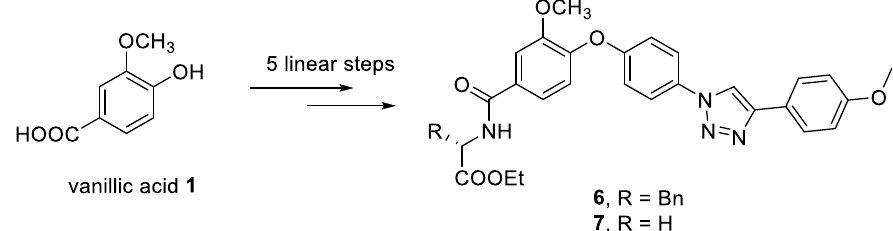
Figure 1. Synthesis of 1,2,3-triazole-aminoacid conjugates 6 and 7 from vanillic acid.